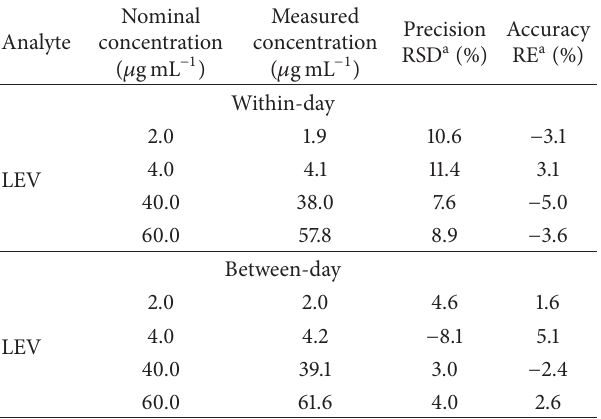
Table 5: Within- and between-days accuracy and